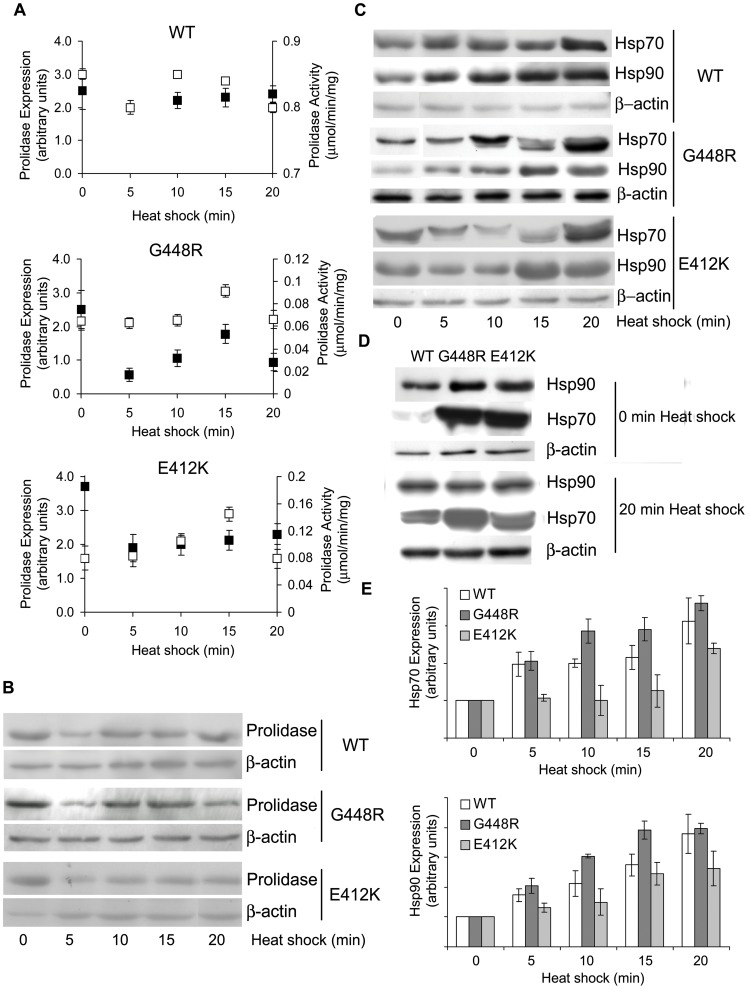
Mutant prolidases stabilization though heat shock proteins induction.(A) Prolidase activity (white square) and protein expression level (black square) of WT, G448R, E412K fibroblasts lysed 16 h after the heat shock (at 48°C).*, p<.05. (B) Representative western blot performed to evaluate the prolidase expression in WT, G448R, E412K fibroblasts 16 h after the heat shock. (C) Hsp70/90 expression in WT, G448R, E412K fibroblasts 16 h after the heat shock. (D) Comparison of Hsp70/90 expression in WT, G448R and E412K at time zero, and after 20 min heat shock. The same exposure time was used in order to emphasize the different expression levels. (E) Densitometric analysis of the Hsp70/90 expression as presented in (C). The proteins expression was quantified by using Quantity One software.